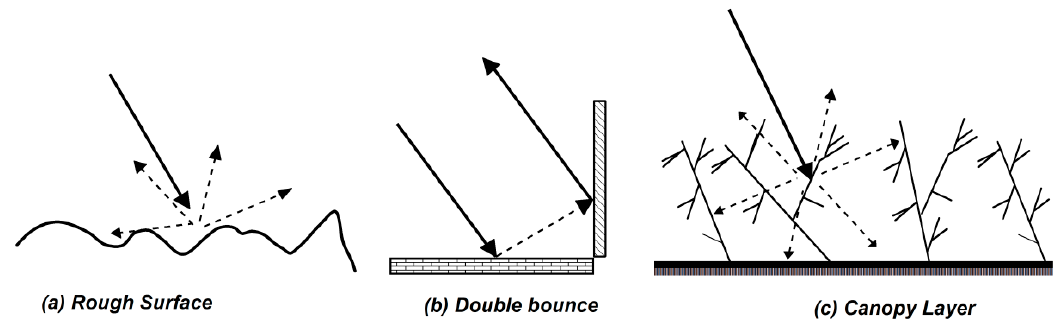
Figure 4. Surface ( a ), double-bounce ( b ) and volume ( c ) scattering mechanisms of electromagnetic (EM) waves.